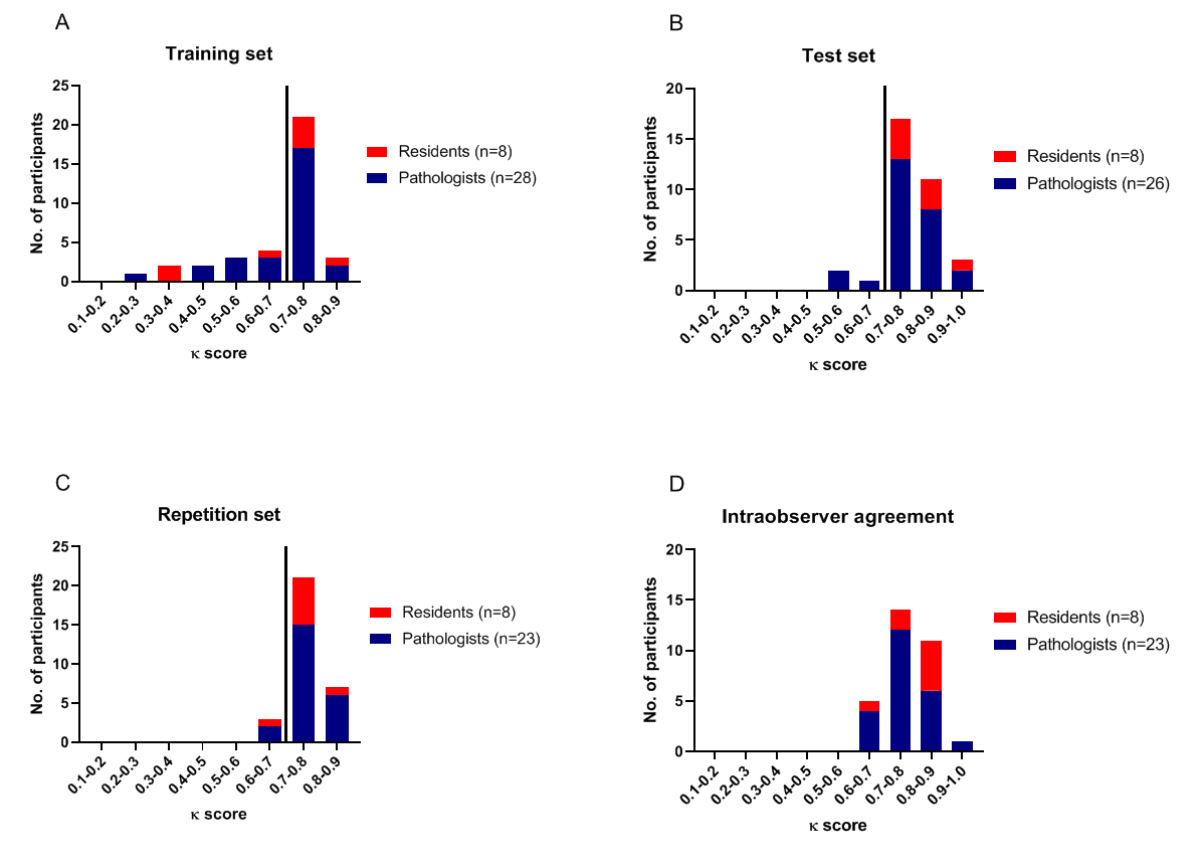
JMIR Form Res 2021 | vol. 5 | iss. 3 | e19408 | p. 4https://formative.jmir.org/2021/3/e19408 (page number not for citation